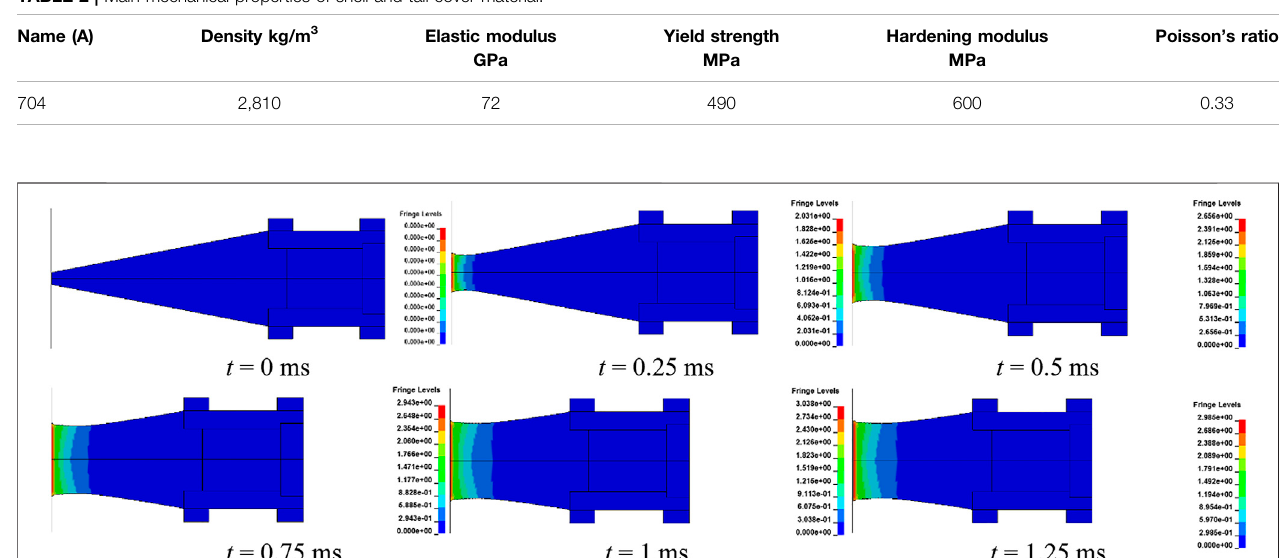
FIGURE 3 | Simulation of the impact process (equivalent plastic strain nephogram).